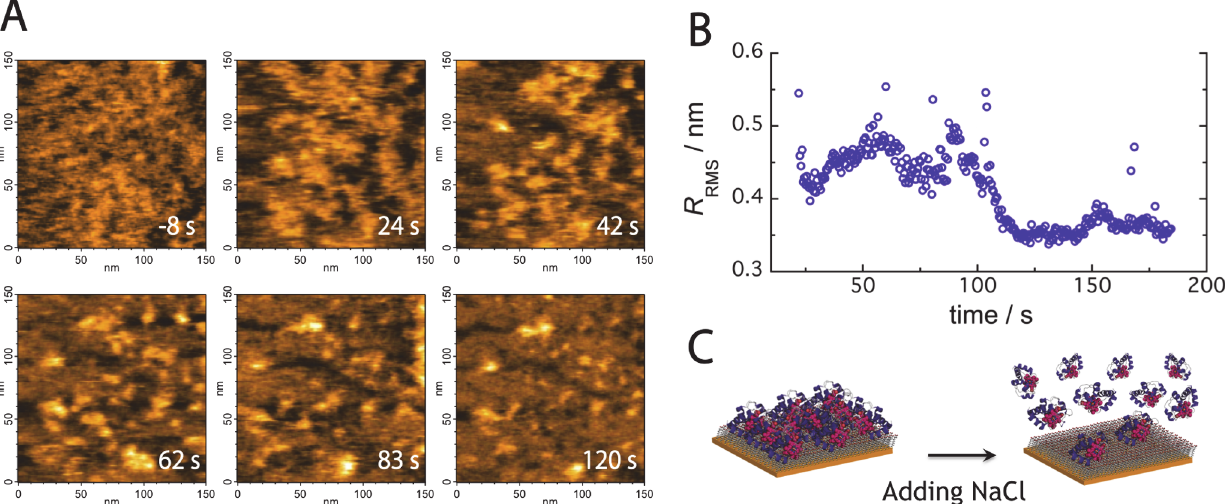
Figure 4. Real-time cyt c desorption processes from the MUA-modified gold electrode. (A) Continuous AFM images of desorbing cyt c molecules. Frame rate, 2 frames/s; image area, 150 × 150 nm 2 . (B) Time evolution of R RMS values at the higher ionic strengths. (C) Schematic of desorbing cyt c molecules from the MUA-modified